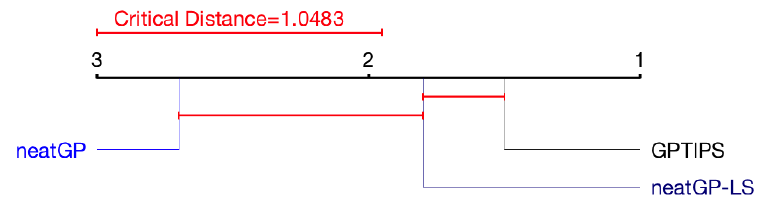
Figure 5. CDD of the Friedman test for the 1–4 scale